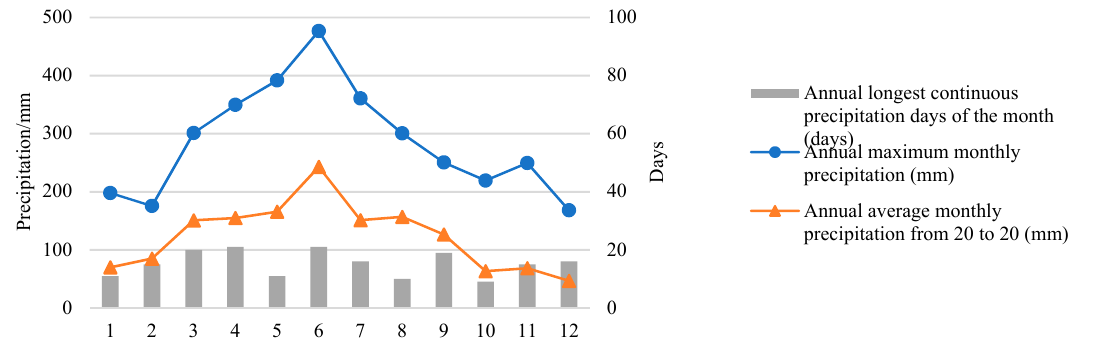
Figure 3. Monthly precipitation data for Jinyun County, Zhejiang Province, China.